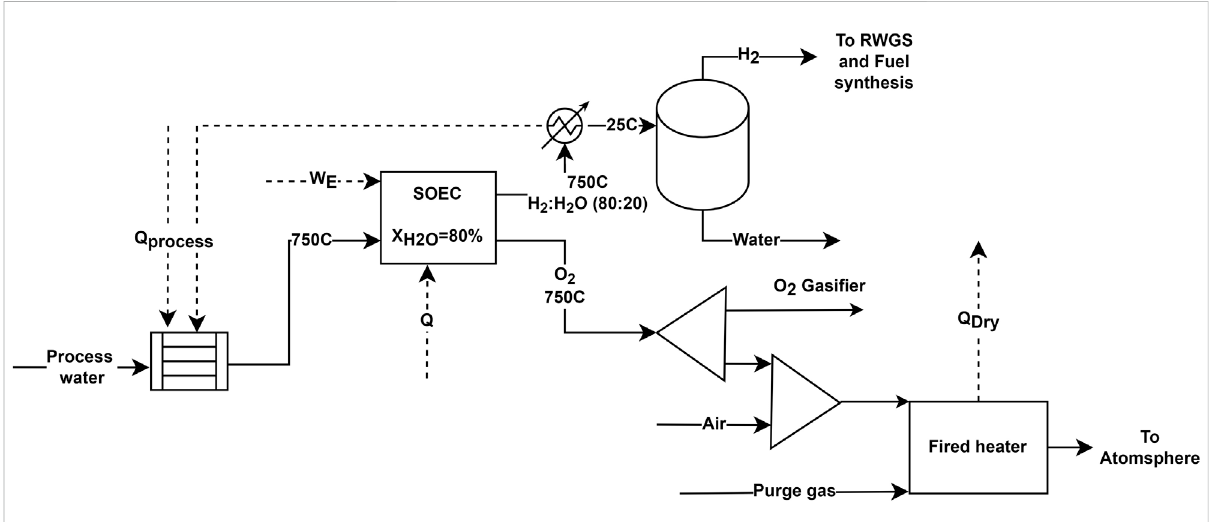
FIGURE 6 Block fl ow diagram of the SOEC model. Heat integration includes WHB and heat economizers, which utilize the heat in the hot ef fl uent